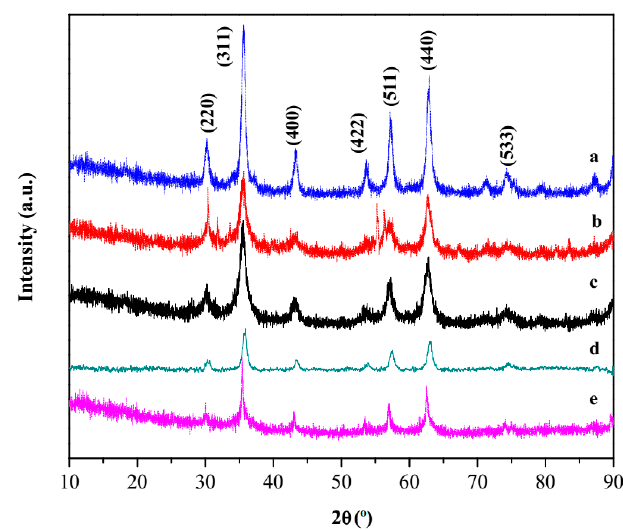
Figure 2. Wide angle X-Ray powder diffraction (XRD) patterns of (a) Fe 3 O 4 -H, (b) Fe 3 O 4 -C, (c) Fe 3 O 4 -H@hpbtz, (d) Fe 3 O 4 -C@hpbtz (prepared in method I), and (e) Fe 3 O 4 @hpbtz (prepared in method II).